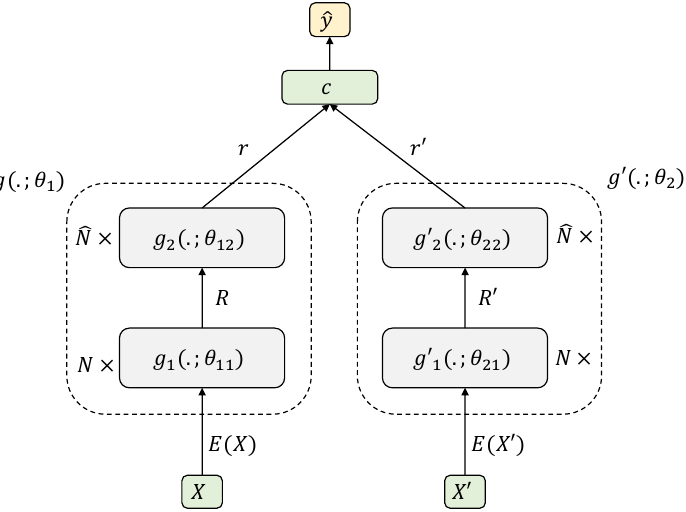
Figure 1. General scheme of the Attentional Extractive Summarization